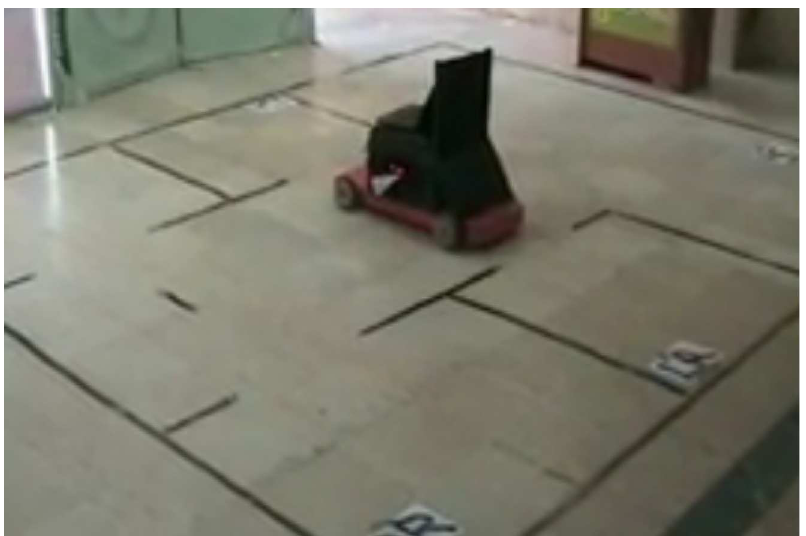
Fig 7. Driving from Node 2 to KT.